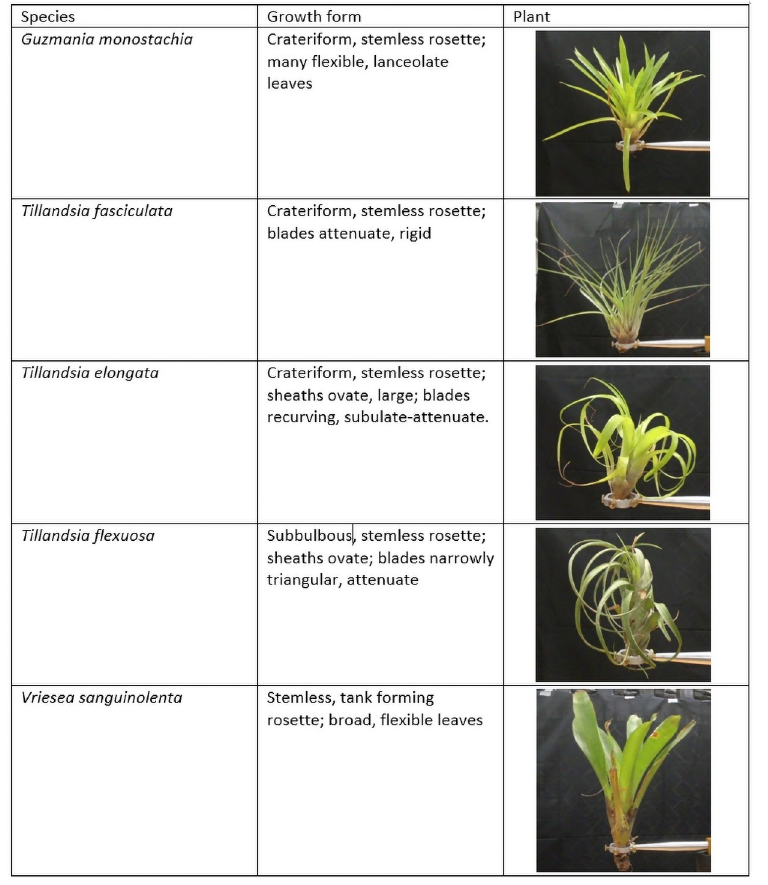
Fig 2. Growth form description of the studied